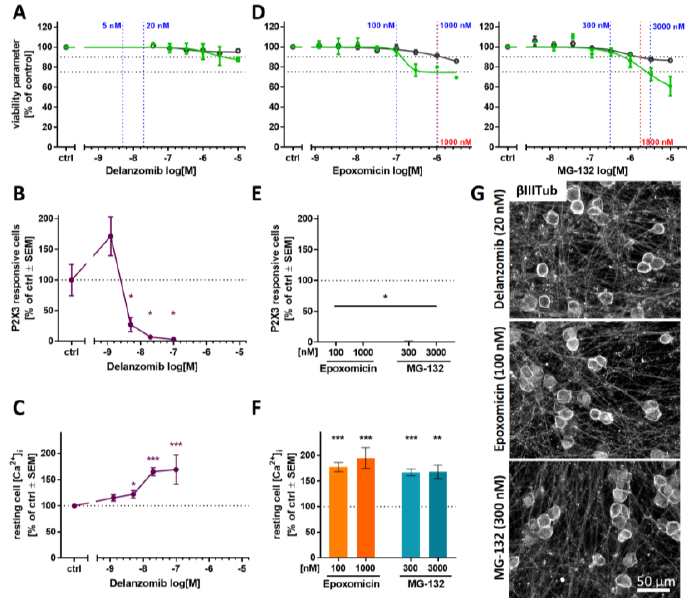
Figure 7. Attenuation of P2X3 signaling and microtubule reorganization as potential PI class effects. The PIs delanzomib ( A – C , G ), epoxomicin, and MG-132 ( D – G ), representing different PI classes, were investigated regarding their effects on various test endpoints. ( A , D ) The compounds’ effects on neurite area and viability were assessed with the standard PeriTox test. Horizontal dashed lines at 90% and 75% indicate the cytotoxicity threshold and the neurite effect threshold, respectively. Vertical dashed lines indicate the lowest cytotoxicity-inducing concentration (red) and concentrations further used for Ca 2+ imaging experiments (blue). ( B , C , E , F ) Sensory neurons (>DoD38) were pre-treated with the test compounds for 24 h before Ca 2+ imaging experiments were performed. ( B , E ) The number of cells responding to stimulation with the P2X3-specific agonist α,β -methylene ATP (1 µM) was assessed. ( C , F ) Baseline fluorescence, indicating the resting intracellular Ca 2+ concentration ([Ca 2+ ] i ) was quantified for whole sensory neuron cultures. ( A – F ) Data are given as % of untreated control cells and are expressed as the mean ± SEM of at least 3 biological replicates. *, p < 0.05; **, p < 0.001; ***, p < 0.0001. ( G ) After differentiation of > 38 days, sensory neurons were exposed to the PIs for 24 h, fixed, and stained for β III-tubulin. Representative immunofluorescence images are shown. The scale bar is given in the images. Further details and quantification of cells with circular β III-tubulin staining are given in Figure S12.